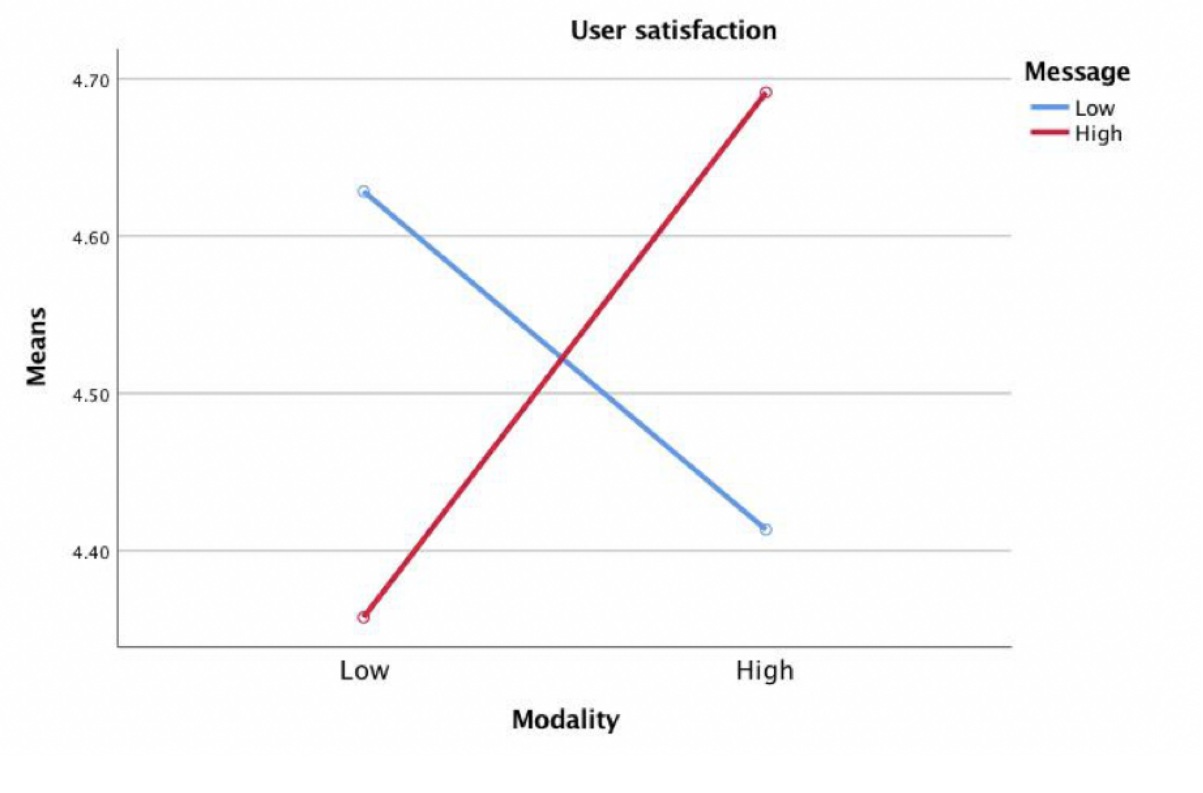
Figure 6. Modality interactivity and message interactivity effect on user satisfaction.